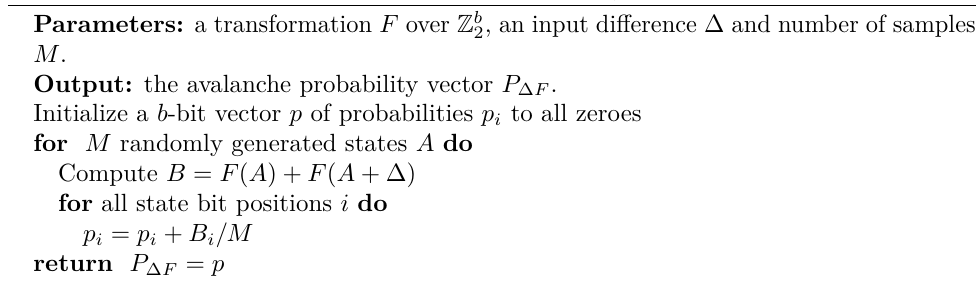
Algorithm 2 Computation of the avalanche probability vector P ∆ F